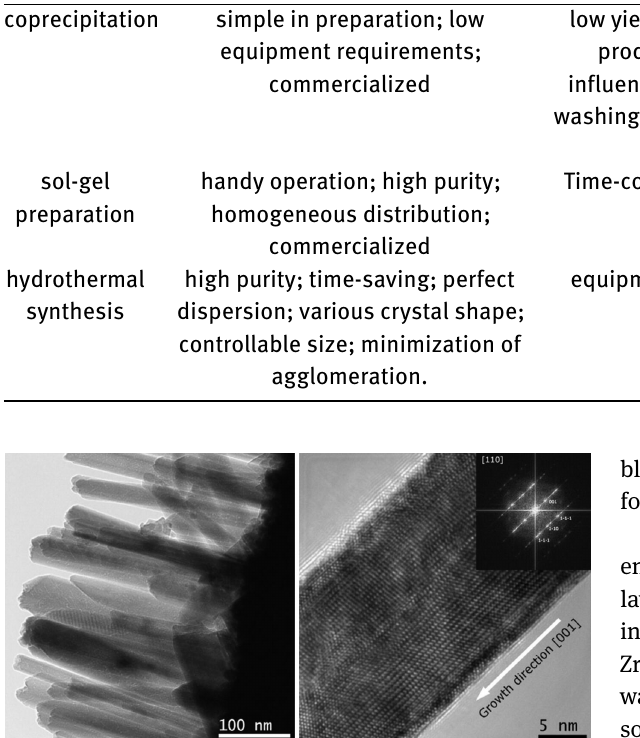
Table 1: Different methods for synthesis of nano-ZrO 2 Synthesis